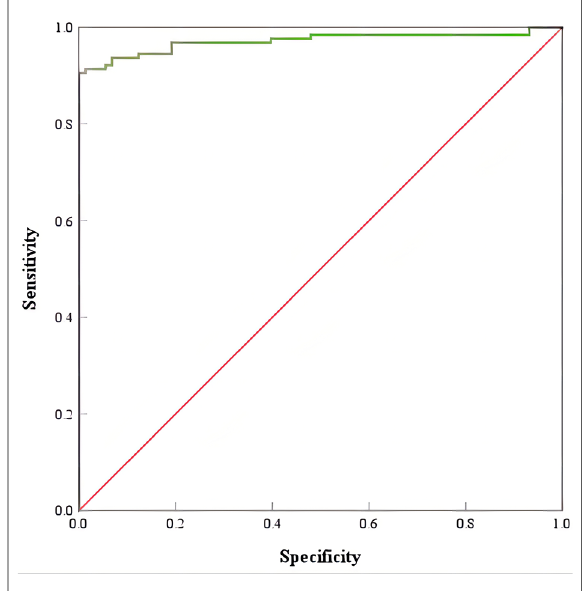
FIGURE 3 ROC curve of Wilson ’ s disease prediction model. ROC, receiver operating characteristic.